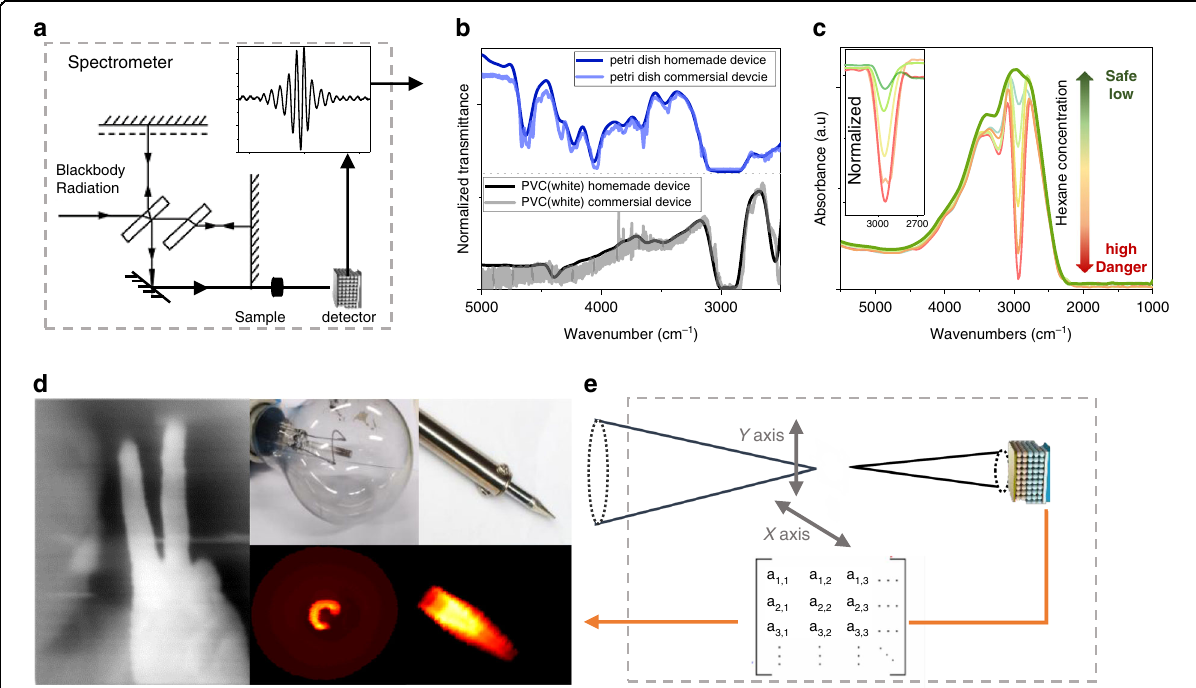
Fig. 4 Homojunction device application. a Schematic diagram of the spectrometer with a homojunction device. b Transmission measured by homojunction device and commercial FTIR. c absorption with different hexane concentrations in the air. d Thermal imaging. e Schematic diagram of one-pixel imaging